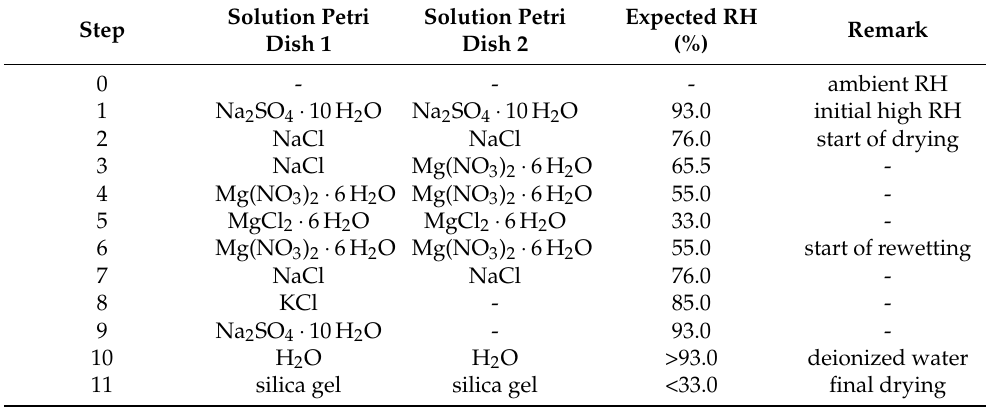
Table 2. Sequence of saturated solutions used to control the RH in the glass